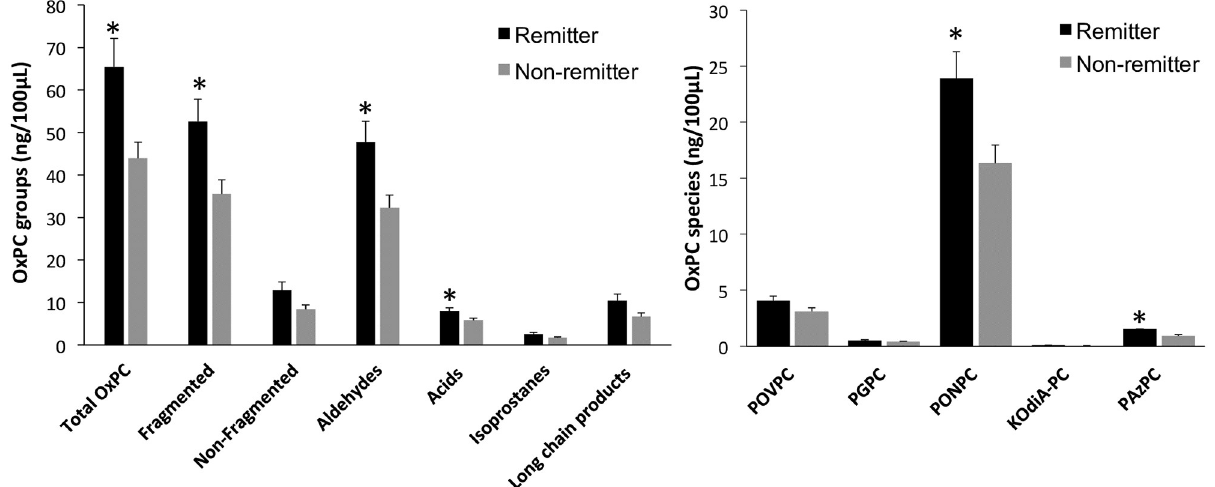
Fig 5. Baseline OxPC levels divided into total OxPCs with subgroups [A] and 5 specific OxPC compounds [B] compared between MDD remitters [n = 22] and non-remitters [n = 26]. Values are mean+SEM. � = p < 0.05.